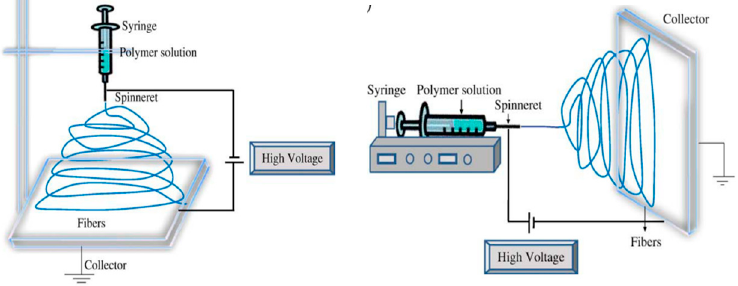
Figure 8. Typical set-up for electrospinning in the vertical ( left ) or horizontal ( right ) configuration, adapted from reference [207]. [A color figure can be viewed in the online issue, which is available at wileyonlinelibrary.com.].